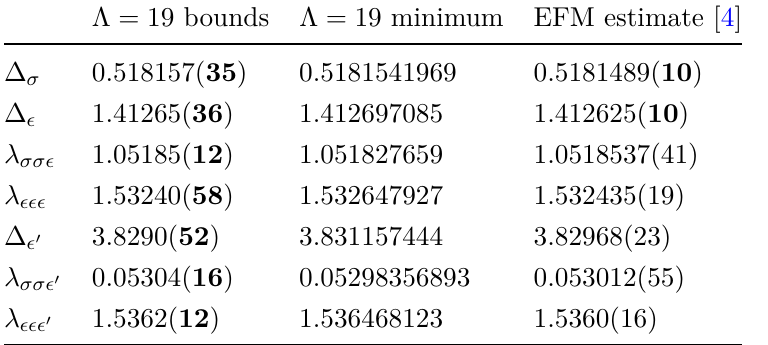
Table 4 . Allowed interval found at Λ = 11 and 19 using the N (∆ (cid:15) , ∆ σ , λ σσ(cid:15) , λ (cid:15)(cid:15)(cid:15) , ∆ (cid:15) 0 , λ σσ(cid:15) 0 , λ (cid:15)(cid:15)(cid:15) 0 ) navigator where we assume ∆ 3 and ∆ 6 and that there is no degeneracy at ∆ σ 0 > (cid:15) 00 > presented in bold is rigorous. The EFM estimates obtained in [4] are included for